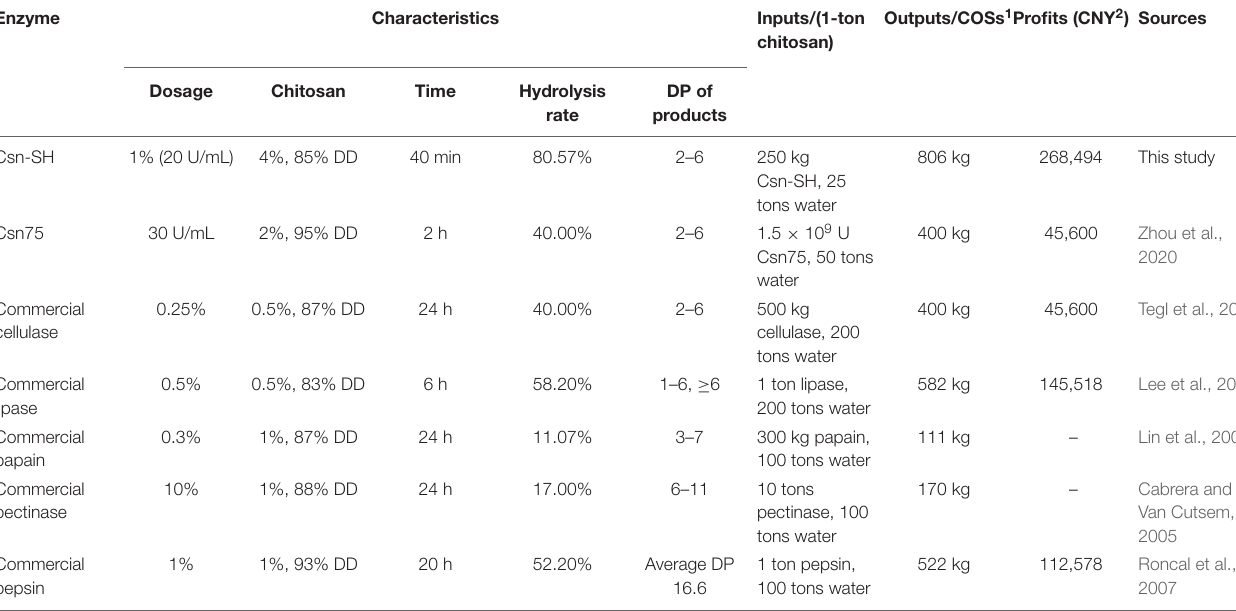
TABLE 3 | The properties and profits of different enzymes for the conversion of chitosan to chitooligosaccharides (COSs). Enzyme